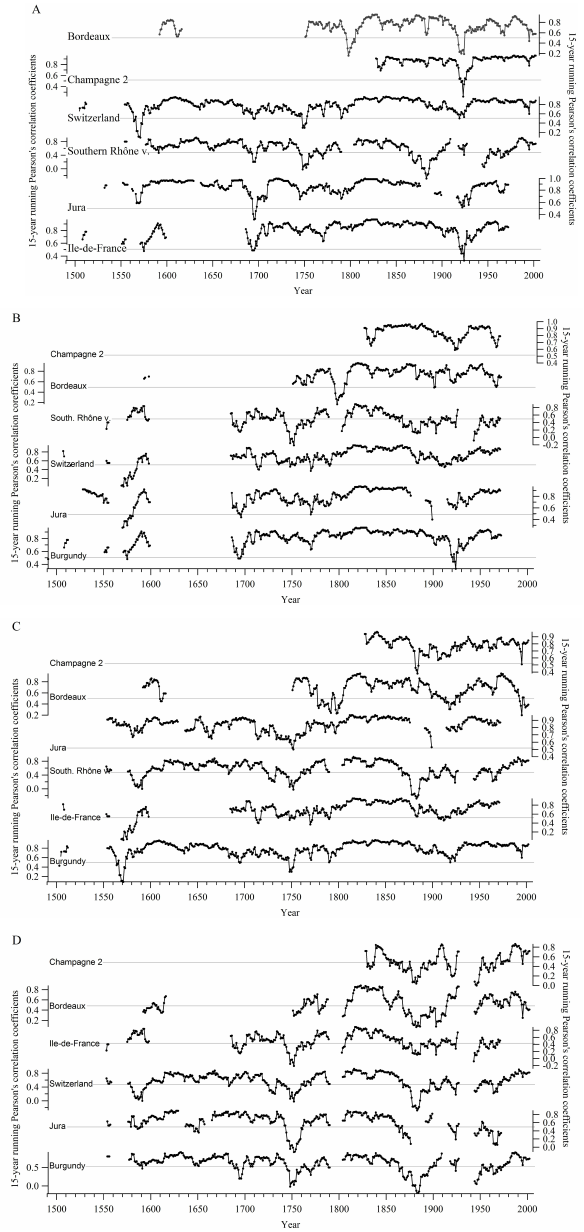
Fig. 4. Variation of the 15-yr running Pearson’s correlation coeffi- cients of GHD-RCS pairwise correlations. The name of the GHD- RCS correlated with Burgundy GHD-RCS (A) , Ile-de-France (B) , Switzerland (C) and Southern Rhˆone valley (D) is reported in each panel. The horizontal lines correspond to the significance level of the PCC (at p = 0 .